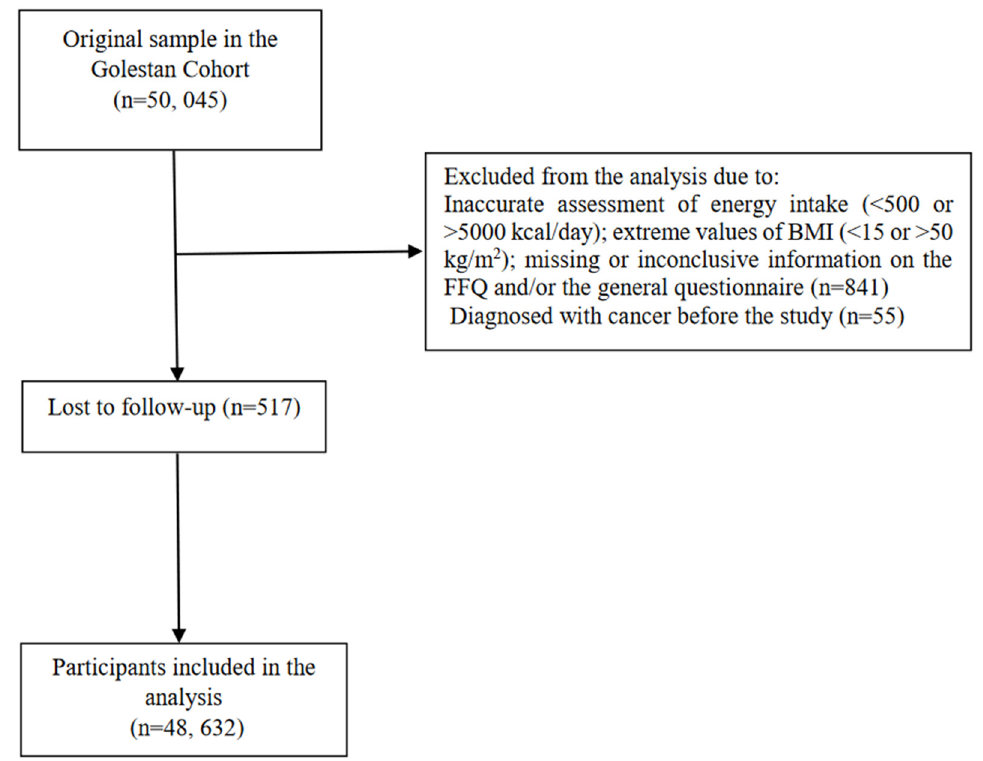
Figure 1. The GCS flow diagram showing the numbers of people who were included in the analyses. The GCS, the Golestan Cohort Study; BMI, body mass index; FFQ, food frequency